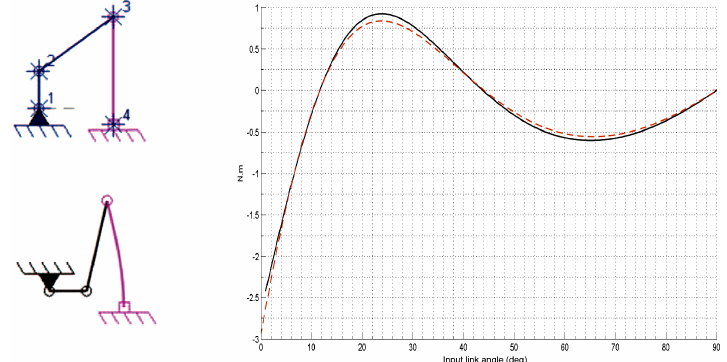
Figure 14. The undeflected mechanism (top left) and deflected position (bottom left). The compliant Link 3–4 is fixed to the ground and connected to Link 2–3 via a pin joint. The comparison of the torque-energy plot with Adams software (right). The dotted line is the Adams output and the solid line is the output by the DAS-2D